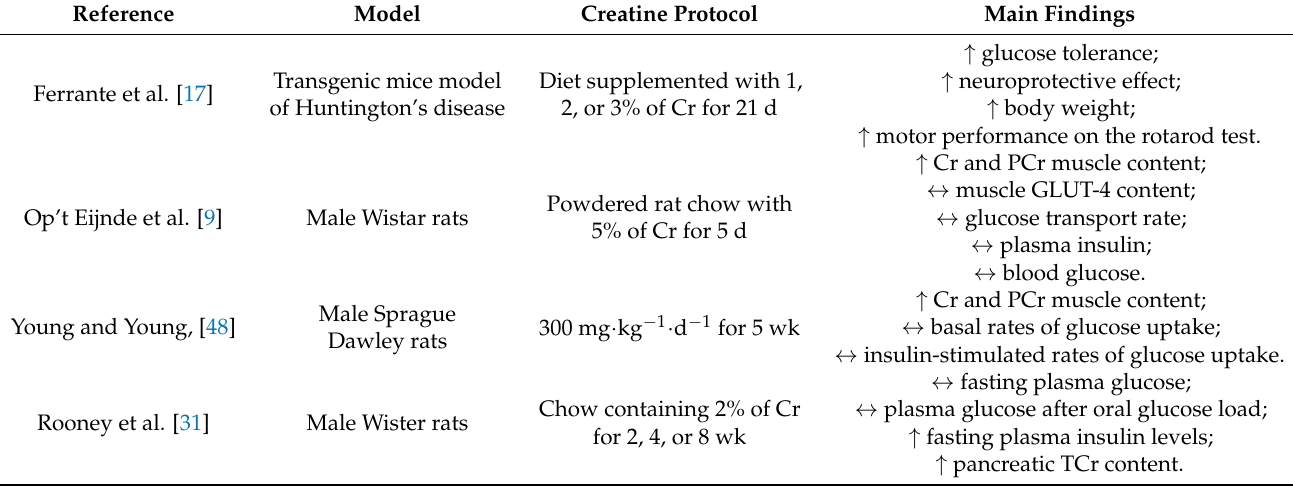
Table 1. Effect of creatine supplementation alone in glucose metabolism in